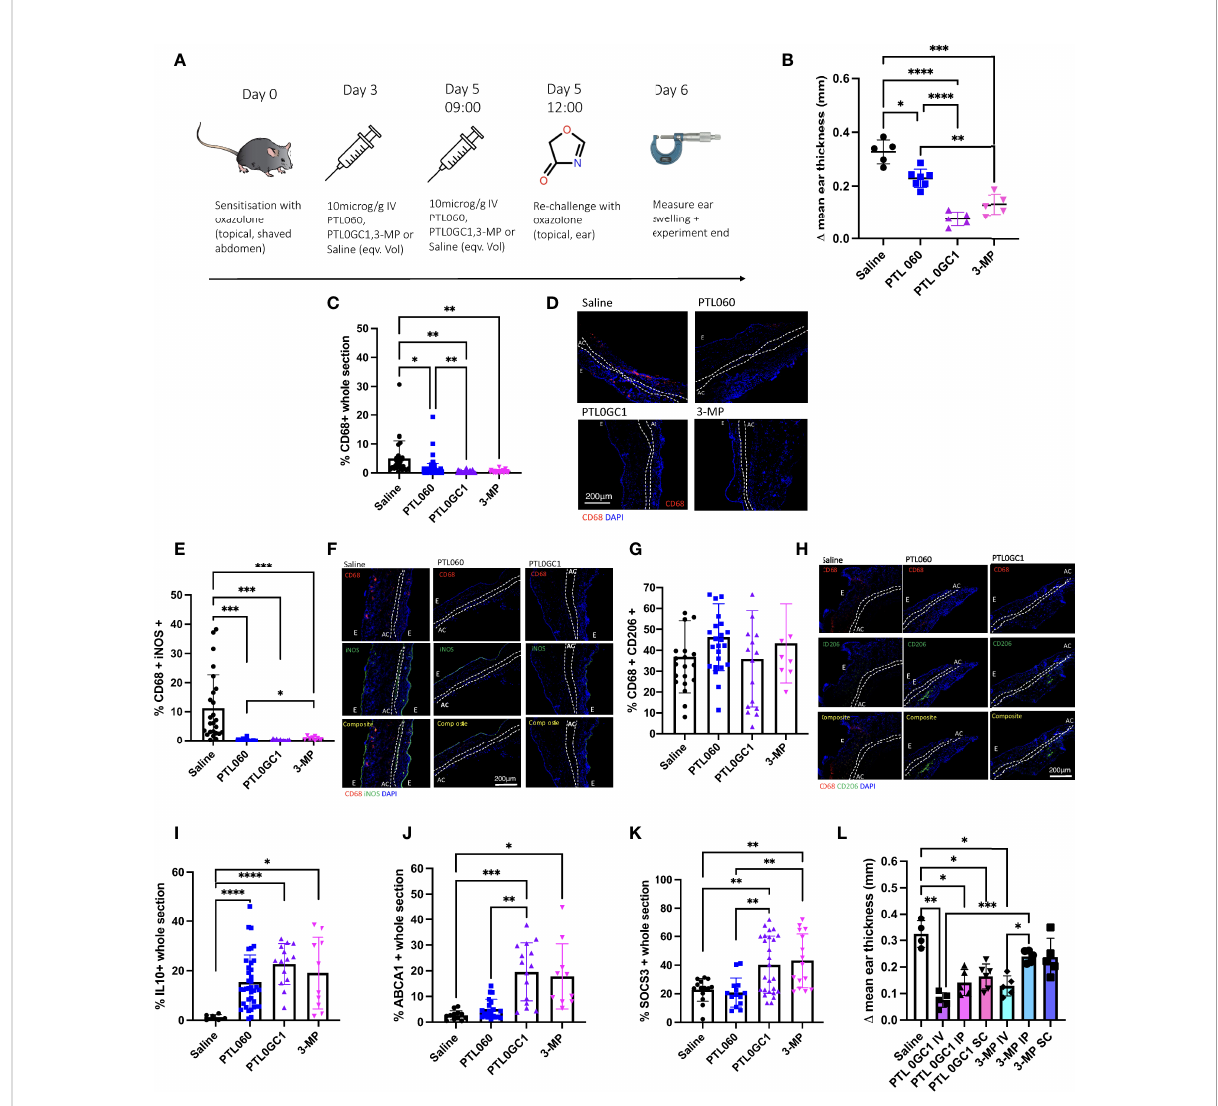
are expressed as change in mean ear thickness between treated (right ear) and untreated (left ear) at 24 hours. For ES data at least 5 measurements were taken per ear and the results averaged. Dotted lines demarcate the auricular cartilage (AC). E= epidermis. All samples where compared using Kruskal – Wallis one-way anova for multiple comparisons. Bar data represents mean +SD. *P <0.05 **P < 0.01 *** P < 0.001 ****P <